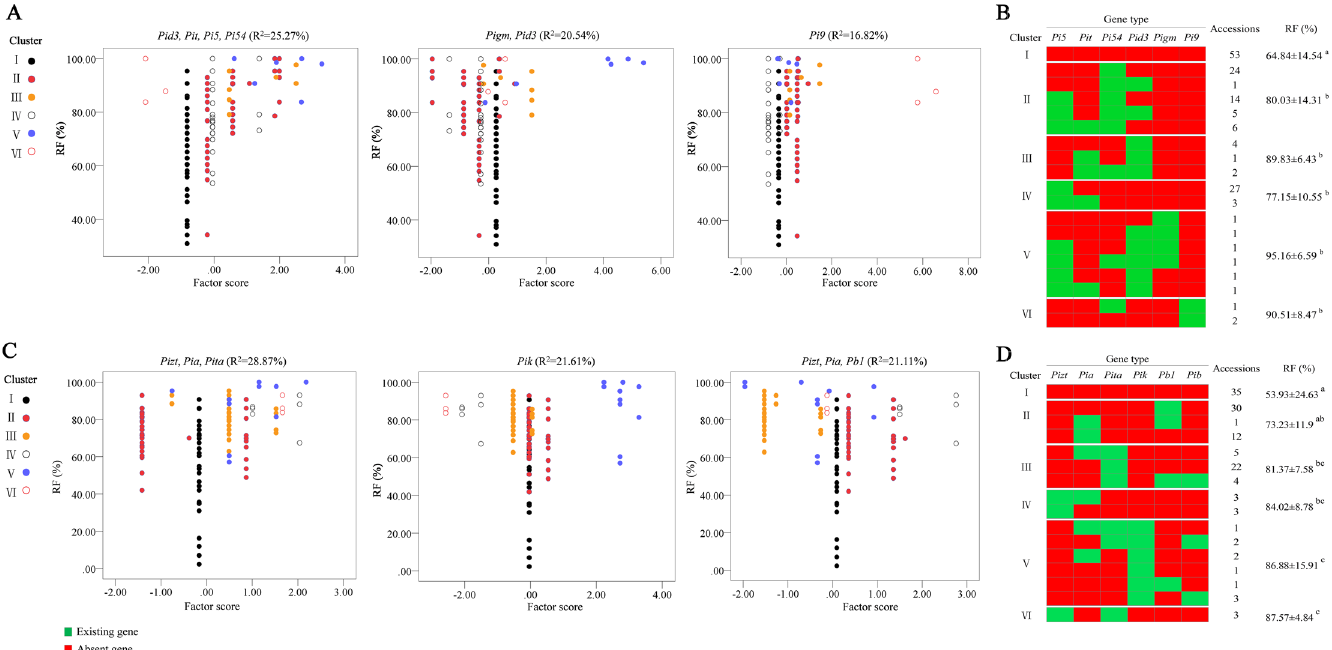
Fig 4. R gene combination factors and gene clusters in indica -type and japonica -type accessions. A. R gene combination factors in indica -type accessions. B. Gene clusters in indica -type accessions. C. R gene combination factors in japonica -type accessions. D. Gene clusters in japonica - type